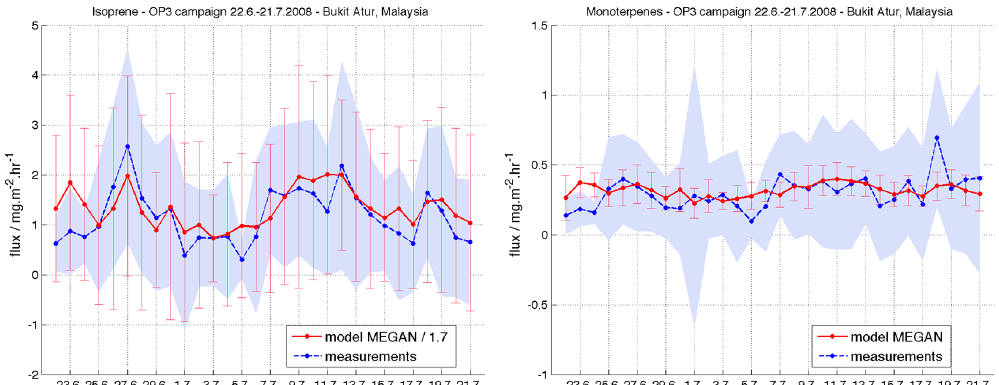
Figure 16. Comparison of isoprene (left) and monoterpene (right) daily mean emission fluxes (mgm − 2 h − 1 ) measured during the OP3 campaign in June–July 2008 (blue dashed line) with flux modelled by the MEGAN model (red line). Modelled isoprene fluxes were divided by a factor of 1.7. Blue shading and red error bars represent 1 standard deviation ( σ ) from the mean measured and modelled values,